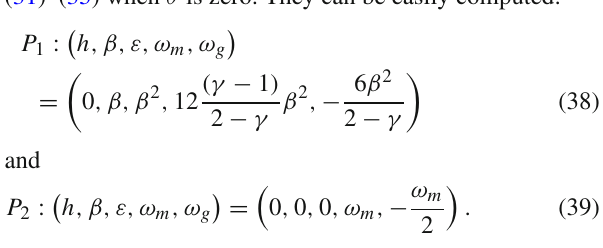
and ω g , as given 3